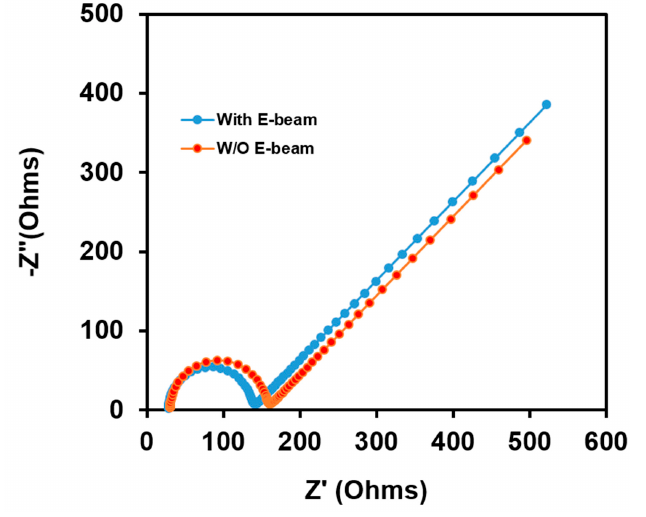
Figure 7. The electrochemical impedance spectra of LLCZN/PEO/LiPF 6 composite with and without e-beam. Figure 8 represents the voltage–time profile of the first four cycles of a cell made with LiCoO 2 |LLCZN/PEO/LiPF 6 |Li at different subsequent currents. It is observed that, as the